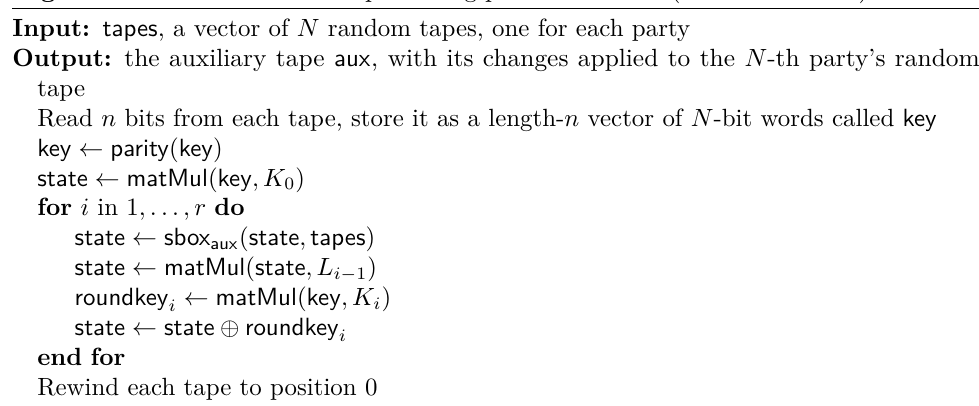
Algorithm 8 Simulation of Preprocessing phase in Picnic2 (after Section 5.1)